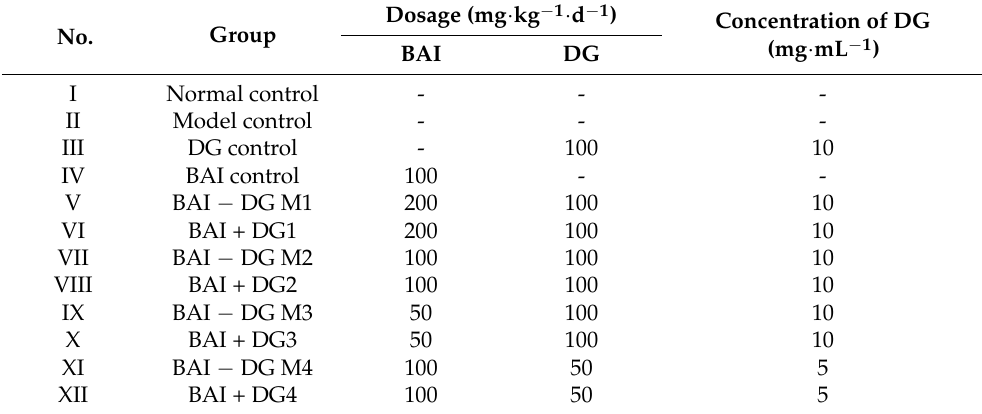
Table 1. Animal grouping and dosage.